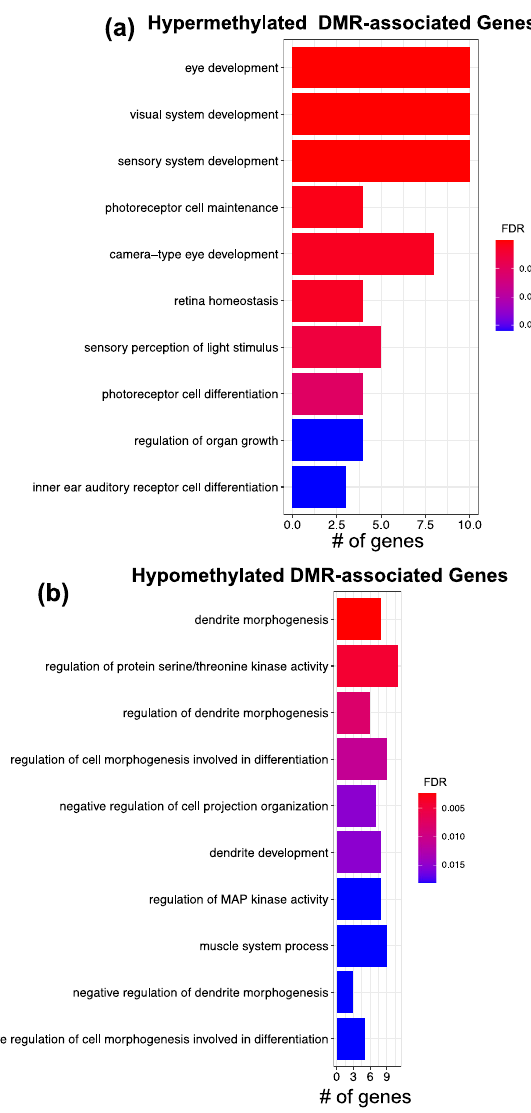
Fig. 4 Pathways and potential regulatory features of regeneration- related DMRs. a , b barplots show the top 10 ontological terms ( y axis) linked to genes that contain hypermethylated (Hyper) and hypomethylated (Hypo) regeneration-associated DMRs, respectively. Bar color depicts the FDR P value for each term. Bar size ( x axis) represents the number of DMR- associated genes identi fi ed for each ontological DNA methylation levels in adult injured RGCs represent the reactivation of embryonic epigenetic signals activated by injury, we fi rst aimed to determine the differences in DNA methylation levels between uninjured adult and embryonic RGCs. To that end, we isolated uninjured embryonic (UE) and uninjured adult (UA) RGCs that were FACS-sorted from non-RGCs, purifying 150,000 ± 86,603 embryonic cells (UE) per retina ( N = 12 retinas) and 166,667 ± 96,225 adult cells (UA) per retina ( N = 12 retinas) (Fig. 1; Video 2). The DNA from these RGCs was treated with sodium bisul fi te prior to whole-genome sequencing to provide DNA methylation levels at more than 25 million CpG dinu- cleotides throughout the RGC genomes (Supplementary Data 1).